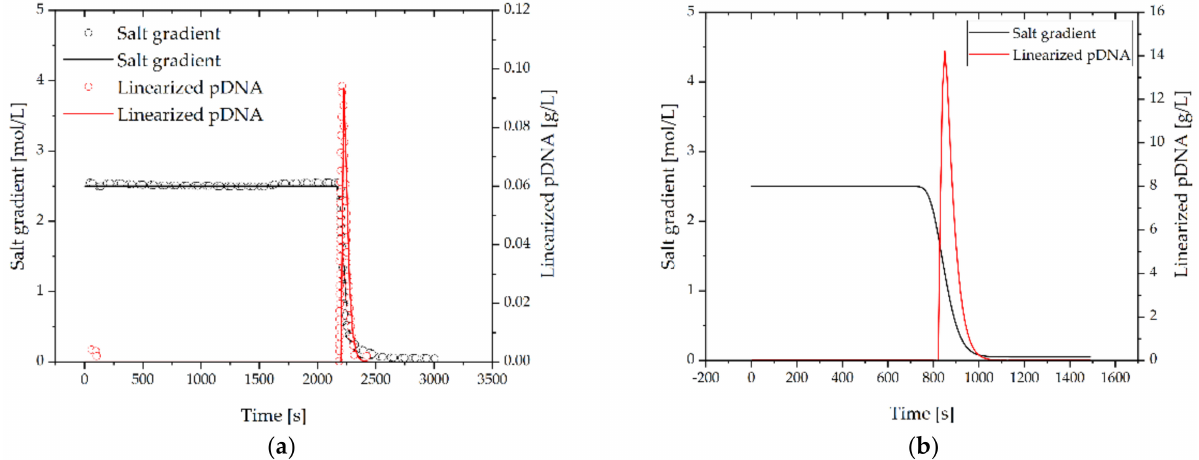
Figure 15. Comparison of the laboratory process ( a ) and the scaled-up process ( b ). In the laboratory process, the literature data is depicted with symbols, the simulated data with